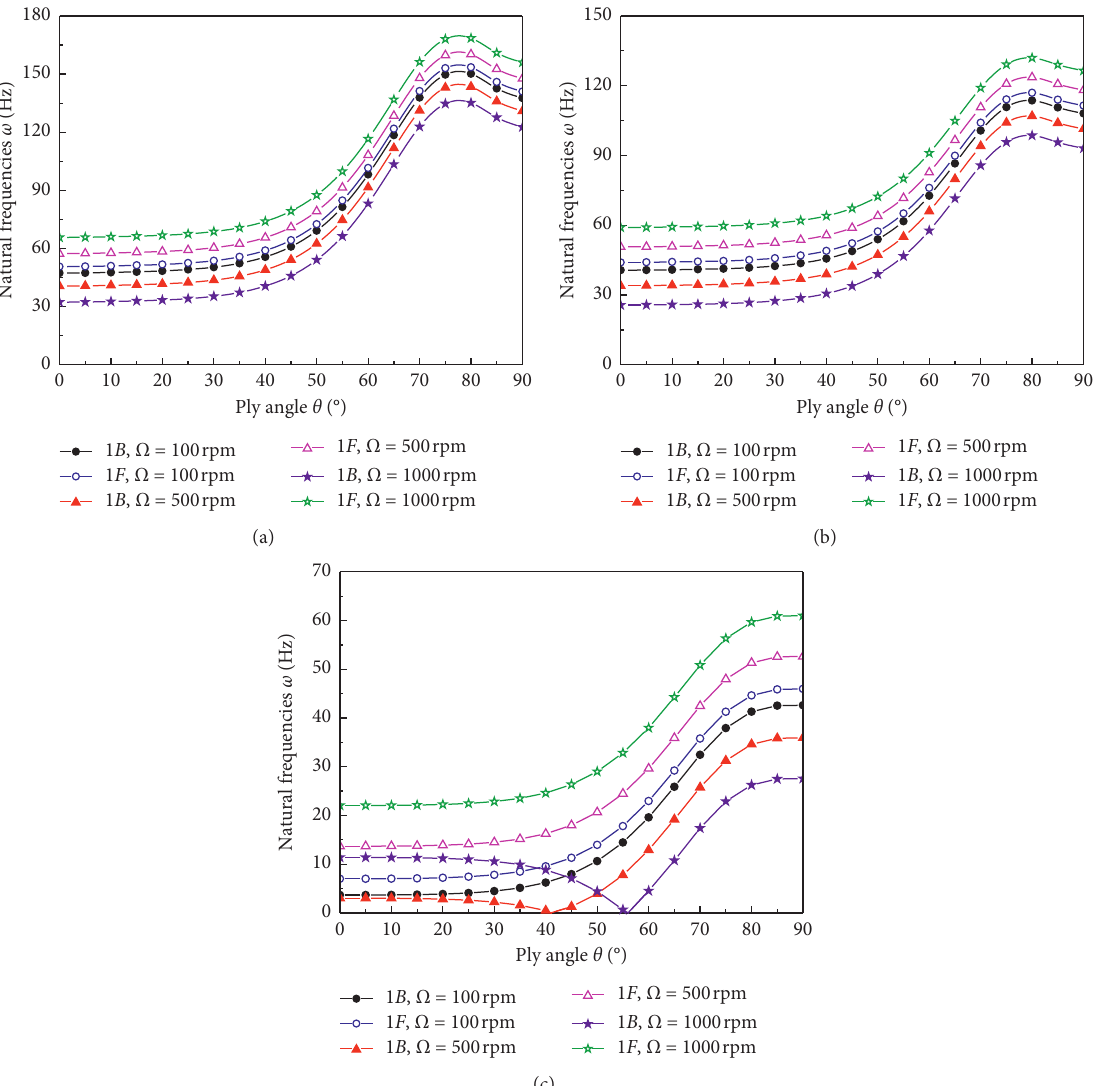
Figure 9: The first natural frequencies versus ply angle of the tapered composite rotating shaft for different rotating speeds � 0 . 05): (a) C-C; (b) S-S; (c) ( σ � 0 . 5 , Vs � 0 . 3 ,T � 50 ° C , ε 0